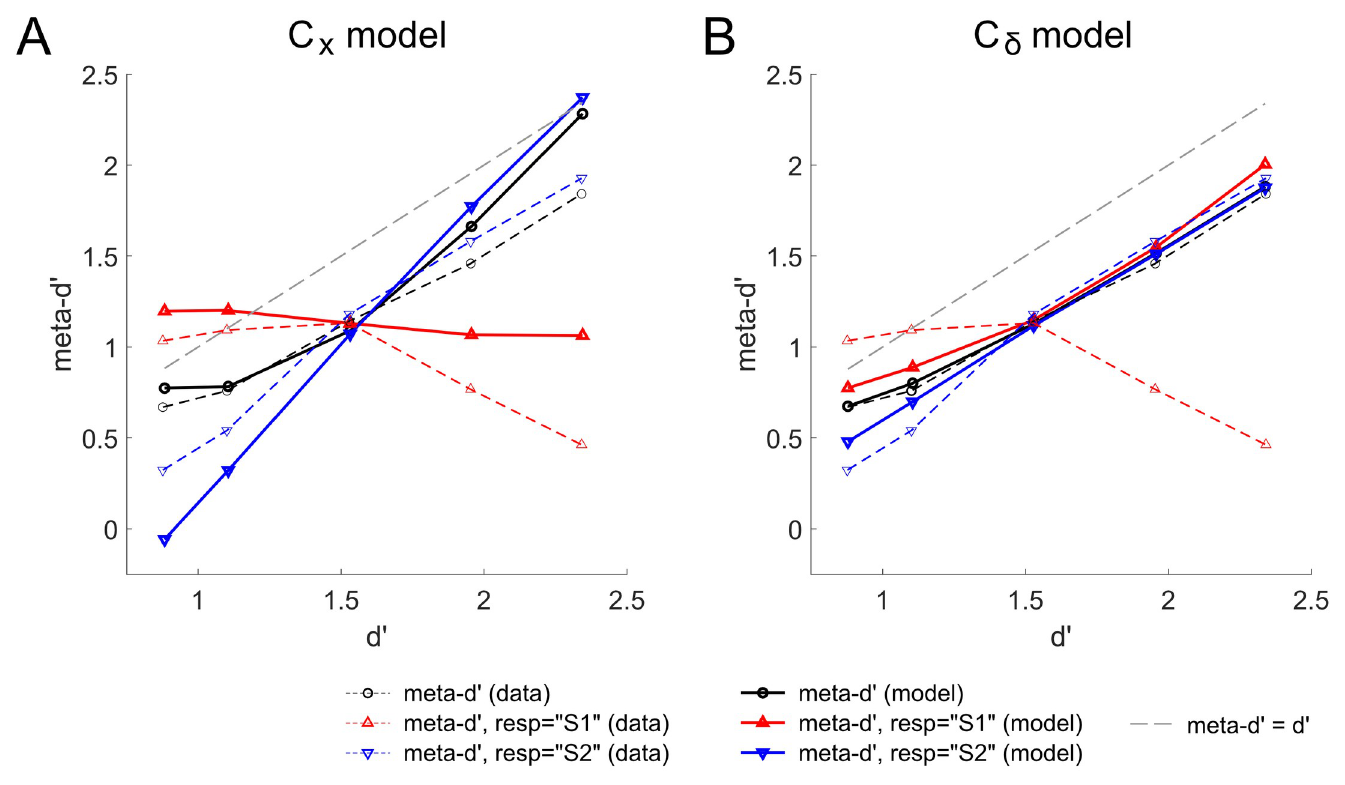
Fig 2. Modeling results for the effects reported by Maniscalco and colleagues [14]. The fitted main C x model (A) reproduces the X-shaped crossover in response- conditional meta-d’ that was observed in the empirical data: as d’ increases, response-conditional meta-d’ for “S2” responses increases whereas meta-d’ for “S1” responses decreases. In contrast, such an X-shaped crossover in response-conditional meta-d’ is not even qualitatively present for the alternative C δ model